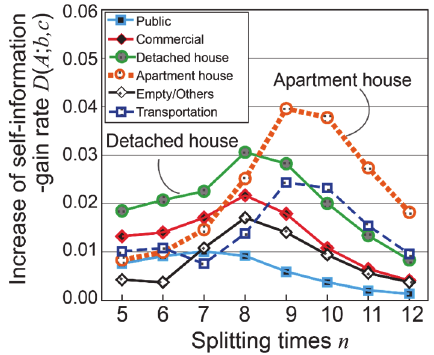
Figure 16 . Self-information-gain rate increase for “apartment house”